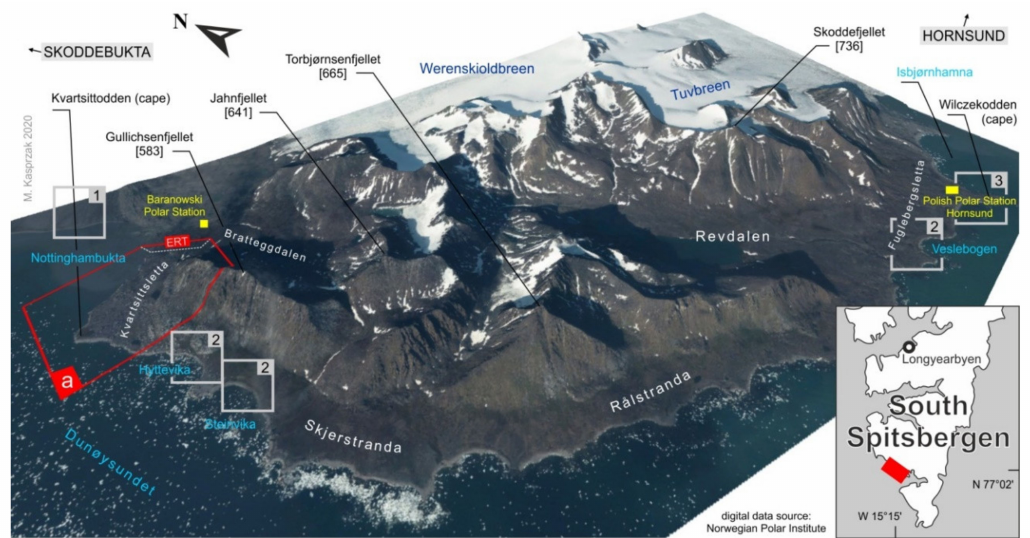
Figure 1. The west coast of Spitsbergen between Skoddebukta (bay) in the north and Hornsund